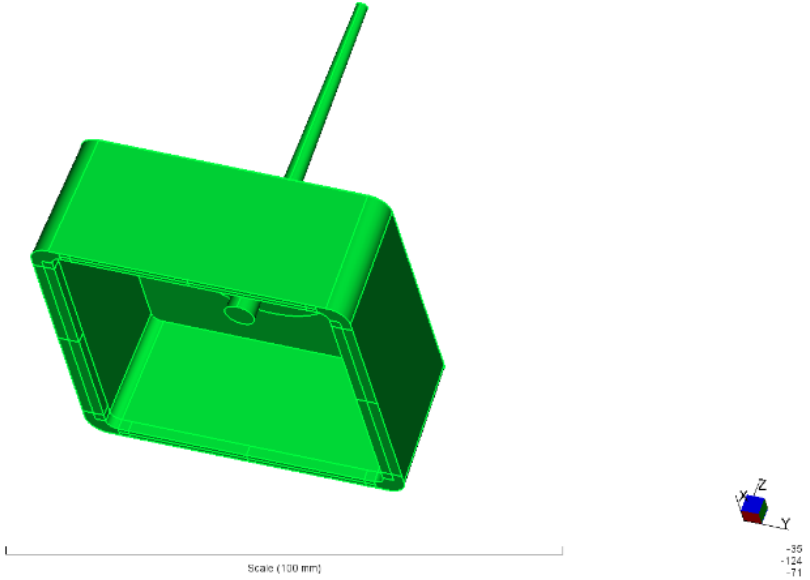
Figure 6. Geometry of the simulated center gated box.